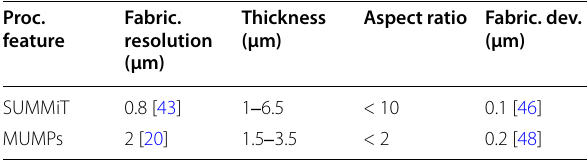
Table 2 Overview of the essential features of the SUMMiT